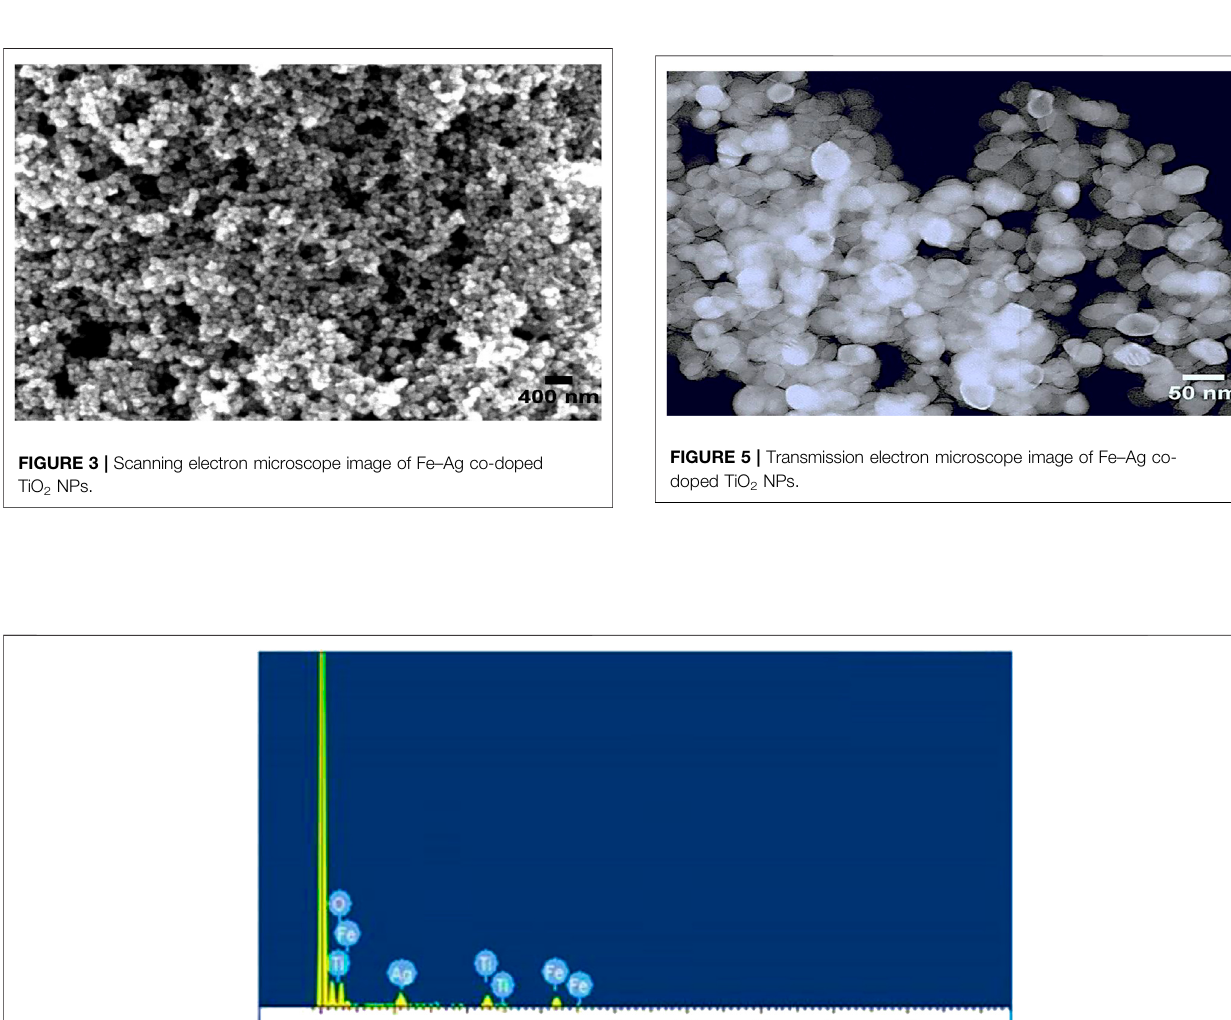
FIGURE 2 | FT-IR spectra of (A) undoped TiO 2 and (B) Fe – Ag co-doped TiO 2 NPs.